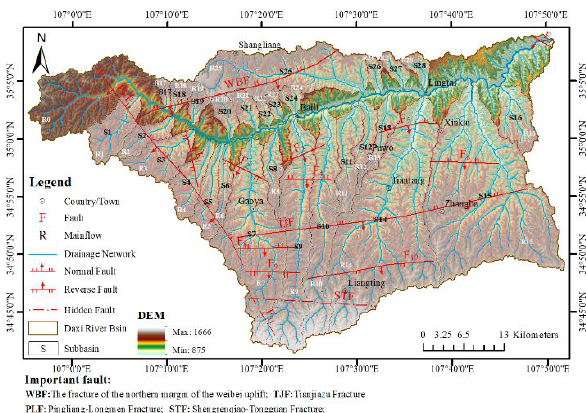
Figure 4. DEM, river basin of Daxihe River